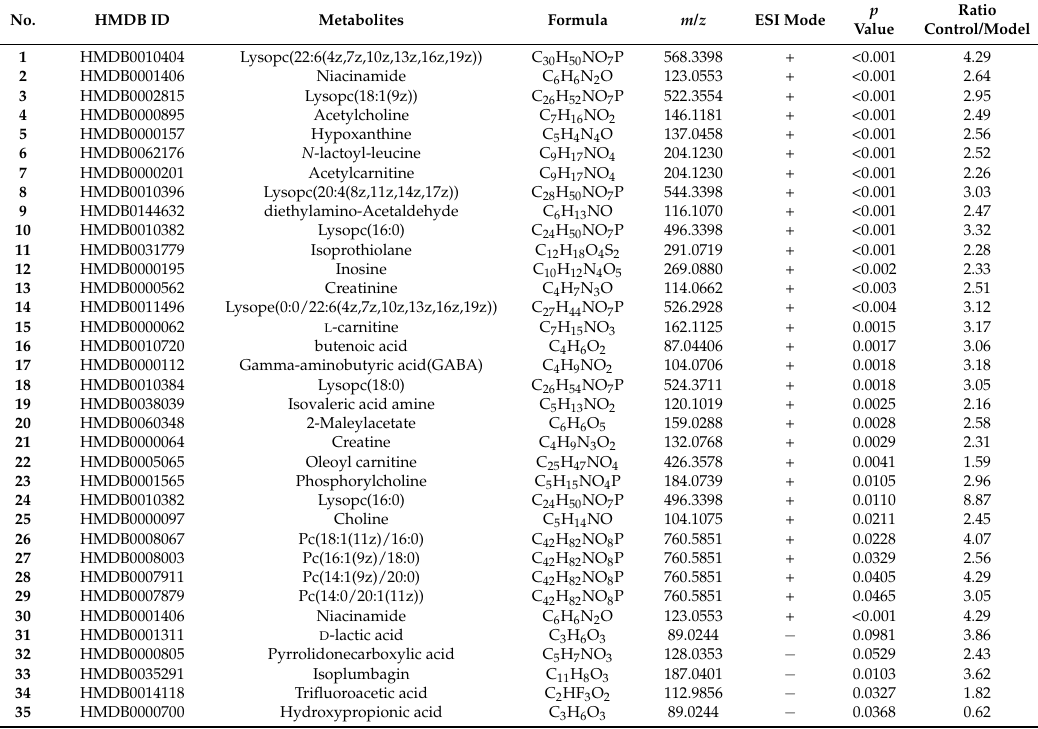
Figure 6. Loading S-plots generated by OPLS-DA analysis in positive mode ( A ) and negative mode ( B ). The x-axis is a measure of the relative abundance of ions, and the y-axis is a measure of the correlation of each ion to the model. Table 1. Cortical differential metabolites between the control group and the model group.